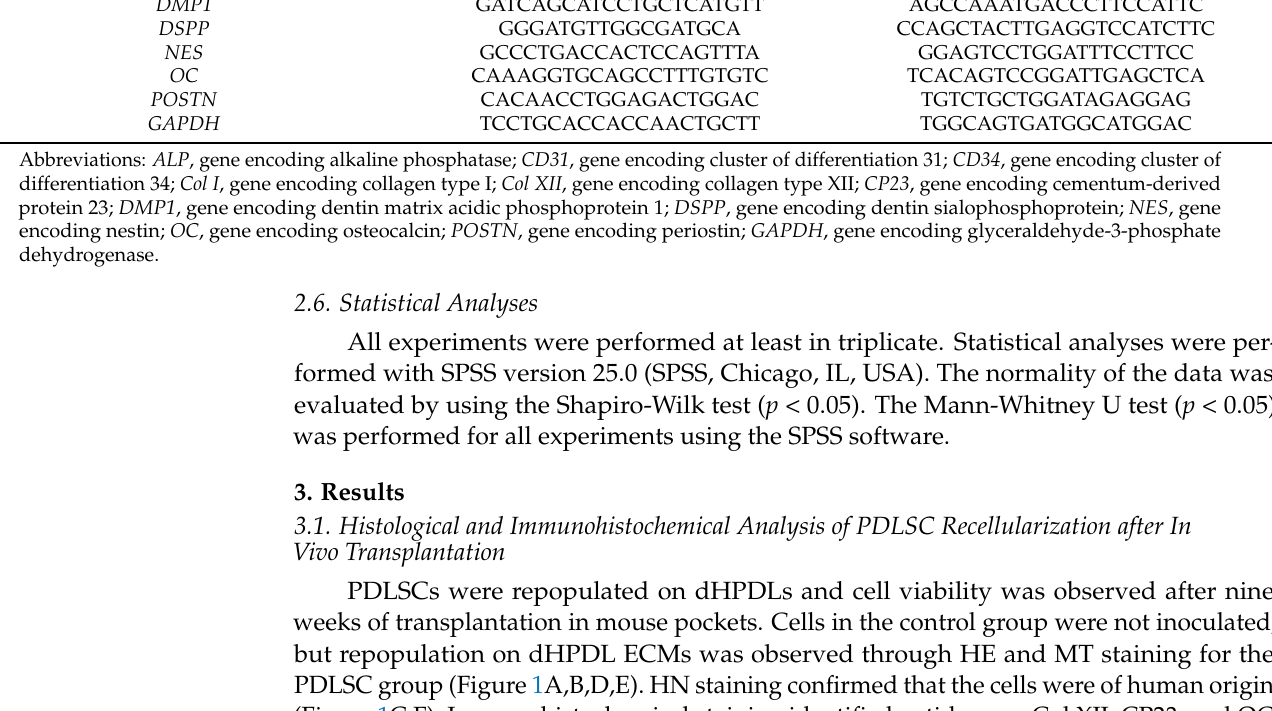
Figure 2. Immunohistochemical staining of PDLSCs recellularization on dHPDL transplants . dHPDL transplants were immunostained with ( A , D ) anti-human Col XII, ( B , E ) anti-human CP23, and ( C , F ) anti-human OC antibodies. The red arrows indicate examples of positively immunostained cells. Scale bars: 20 μ m. Abbreviations: PDLSCs, periodontal liga- ment stem cells; dHPDL, decellularized human periodontal ligament; Col XII, Collagen type XII; CP23, cementum-derived protein 23; OC, osteocalcin. 3.2. Gene Expression in Recellularized PDLSCs qPCR was performed to assess the expression of genetic markers in recellularized PDLSCs. There was a significant difference in the expression levels of CP23, Col I, Col XII, OC, and alkaline phosphatase (ALP) between the PDLSC and control group. In particular, gene expression upregulation was observed in OC (4.59 ± 3.97-fold) and CP23 (8.46 ± 3.87-fold). However, there was no significant difference in the expression levels of perios- tin (POSTN) (Figure 3).